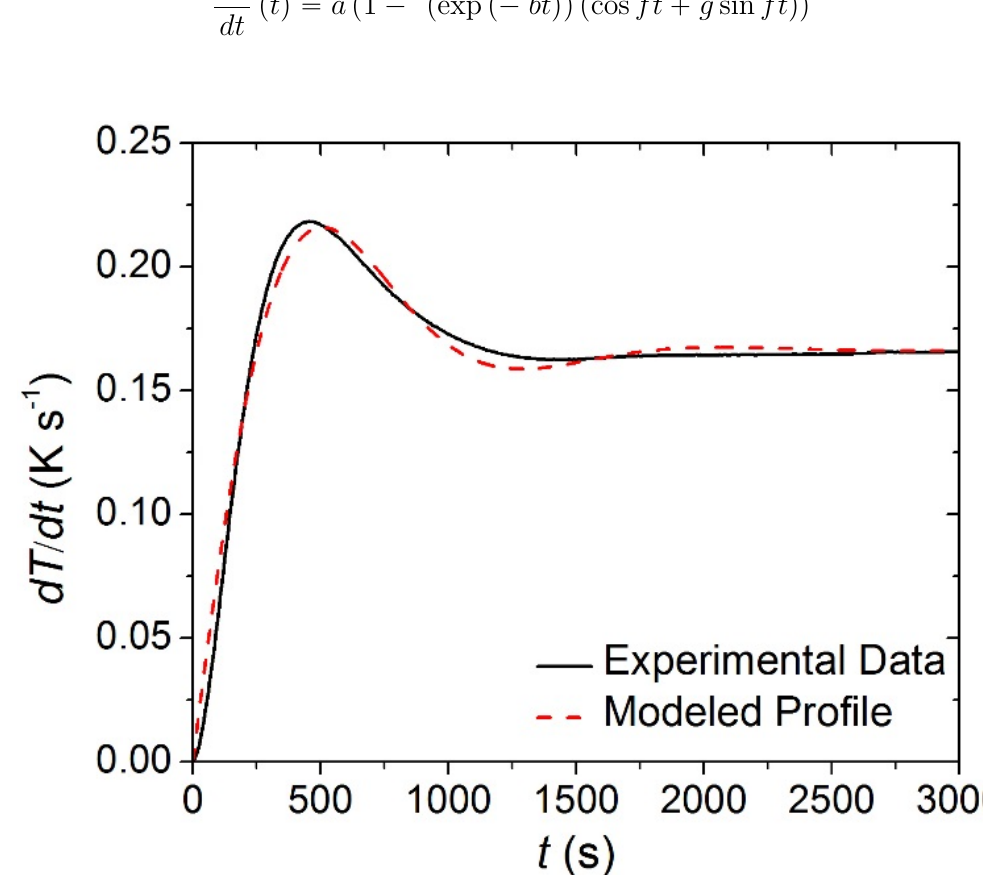
Figure 6. Experimentally observed and modeled heating rate histories typical of the Simultaneous Thermal Analysis (STA). The coefficients for Equation (11) that describe the modeled curve are the following: a = 0.166 K s − 1 , b = 0.0024 s − 1 , f = 0.004 s − 1 , g = − 0.0623.